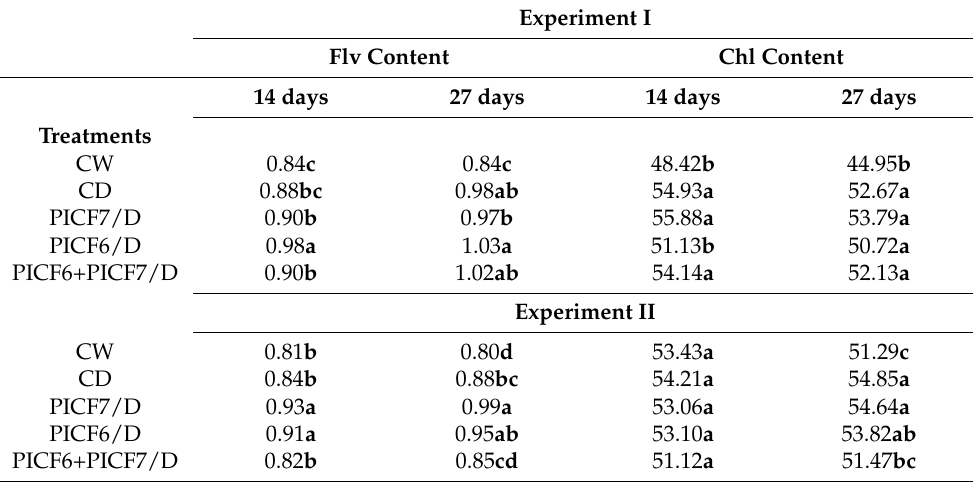
Table 2. Measurements of total flavonoids (Flv) and chlorophyll (Chl) in olive (cv. Picual) leaves subjected to drought